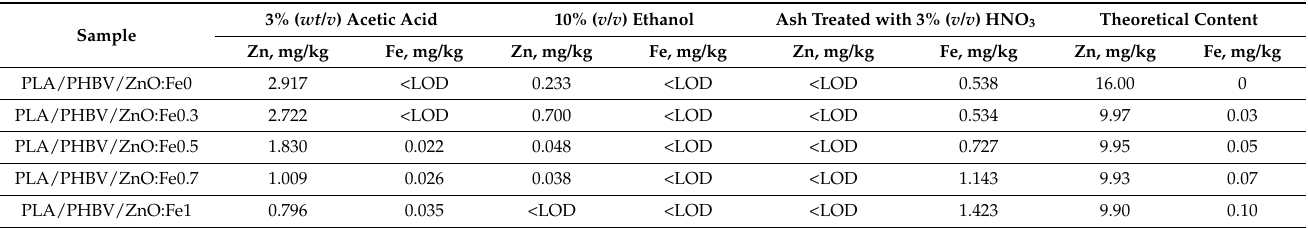
Table 4. Specific migration of Zn and Fe in 3% ( wt / v ) acetic acid, 10% ( v / v ) ethanol, and, after the treatment of ash with 3% ( v / v ) HNO 3 , 2 h at 70 ◦ C.